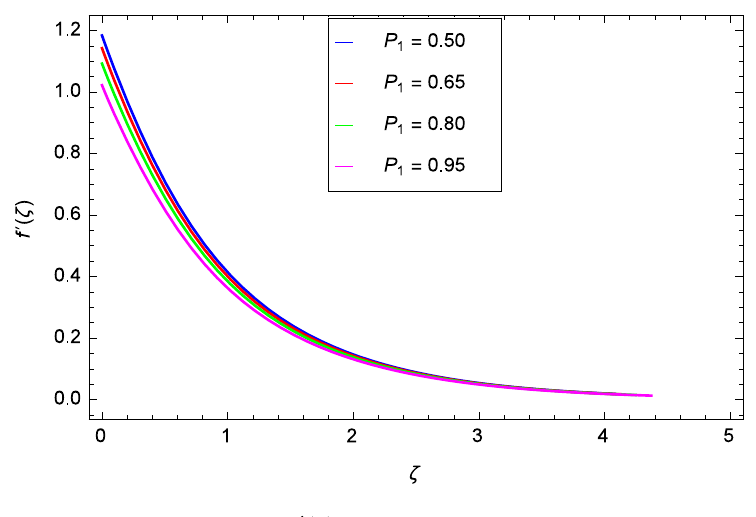
Figure 4. Influence of P 1 on f (cid:48) ( ζ ) .